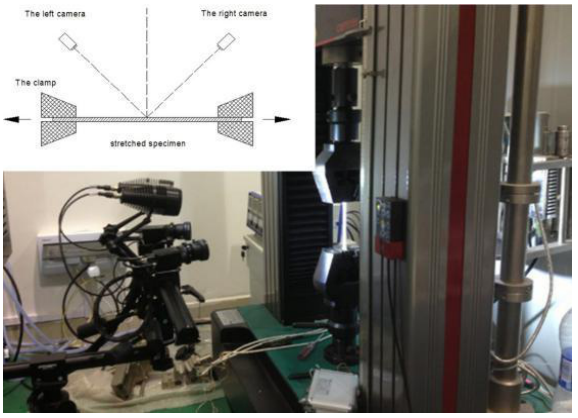
Figure 1. The stretching and testing system.